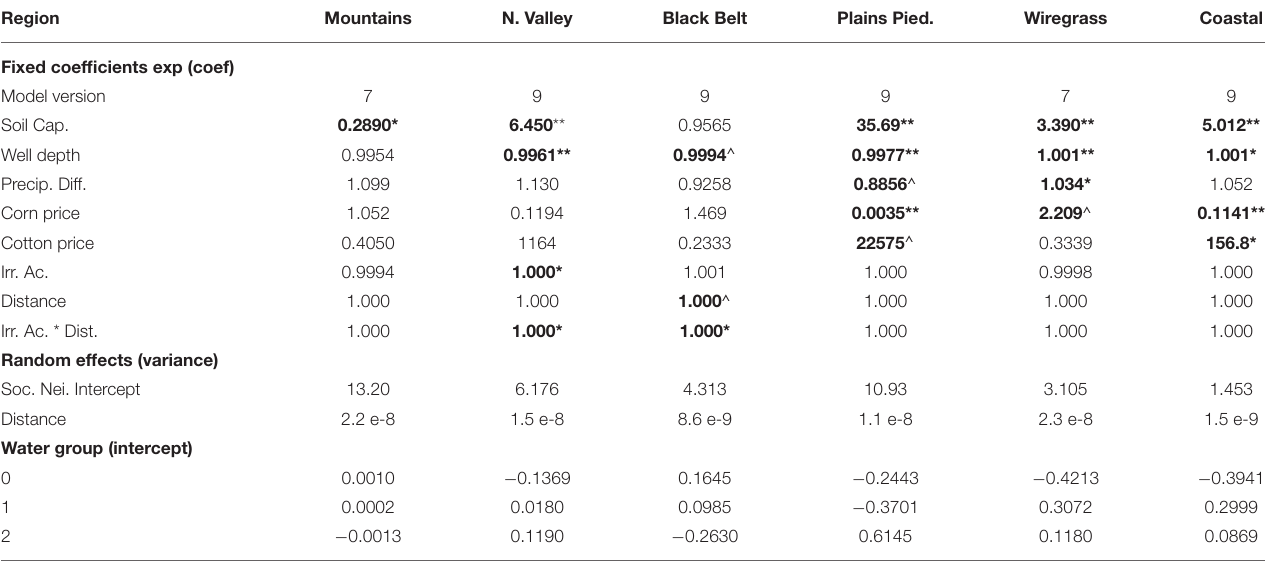
TABLE 6 | Estimates of group intercepts and fixed and random effects by agricultural region. Region Mountains N. Valley Black Belt Plains Pied. Wiregrass